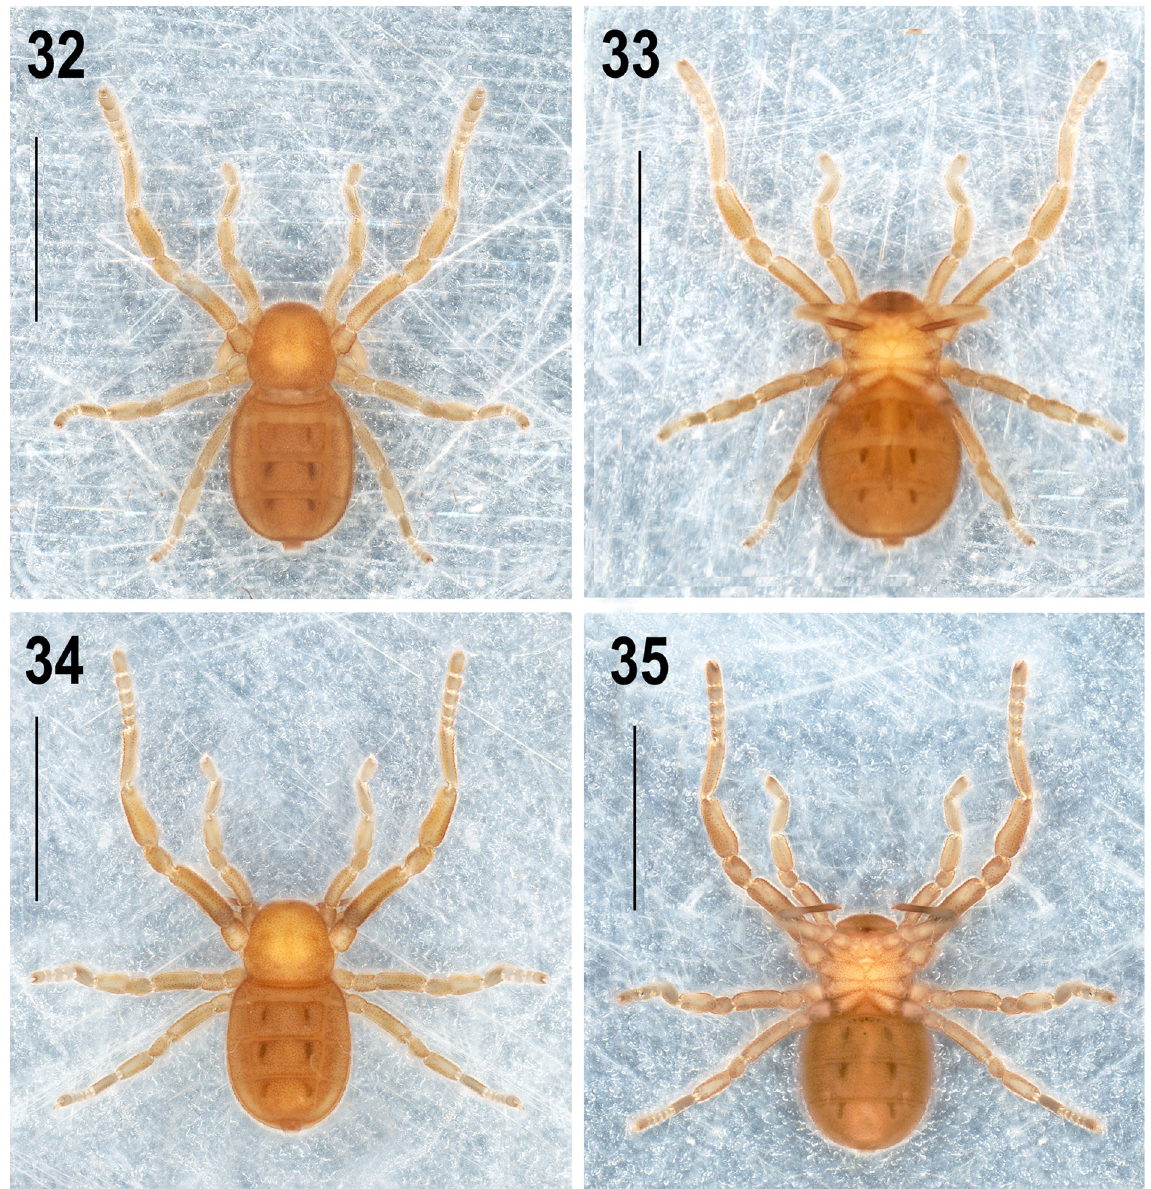
Figs 32–35. Pseudocellus giribeti sp. nov. Paratypes (MCZ 80010). 32–33 . Deutonymph, habitus, dorsal and ventral views. 34–35 . Tritonymph, habitus, dorsal and ventral views. Scale bars = 2